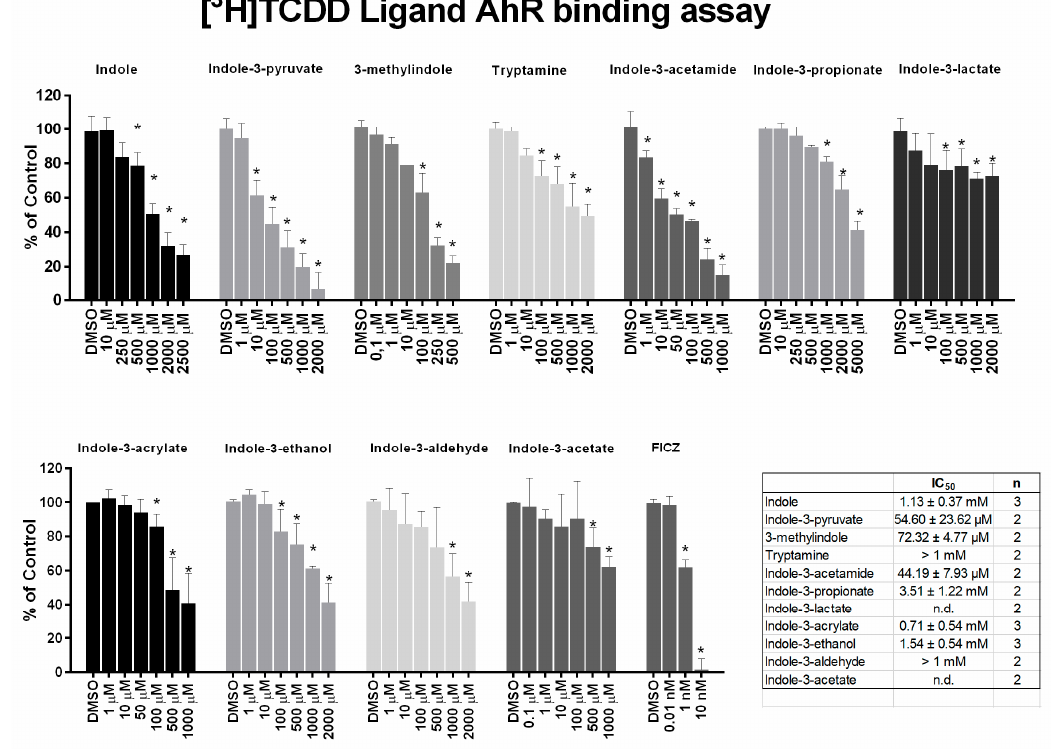
Figure 2. Competitive radio-ligand binding assay. Cytosols from Hepa1c1c7 cells were incubated with vehicle (negative control; 0.1% V / V ), FICZ (positive control; 0.01 nM – 10 nM), TCDF